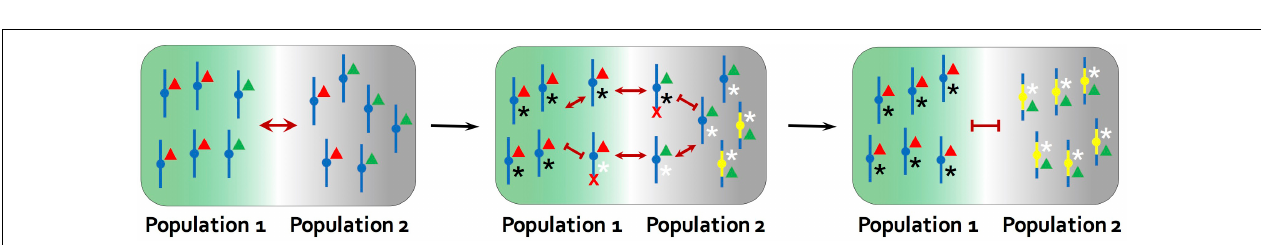
FIGURE 4 | The model for the role of inversions in speciation proposed by Trickett and Butlin (1994). An inversion facilitates speciation by suppressing recombination between genes involved in local adaptation (red and green triangles) and those underlying assortative mating traits, as such flowering time (black and white asterisks). The ancestral chromosome carries mixtures of adapted and maladapted alleles due to recombination. Individuals that are locally adapted to the environment of population 2, but carries the white assortative mating allele, will tend to mate with individuals adapted to the other environment and produce maladaptive offspring in population 2. Individuals with a new inversion that captures only the locally adapted alleles and black assortative mating allele do not suffer the reproductive cost from recombination. The inversion is therefore favored and contributes to further divergence between populations. Red crosses indicate that chromosomes carrying maladaptive combinations of alleles are eliminated in each